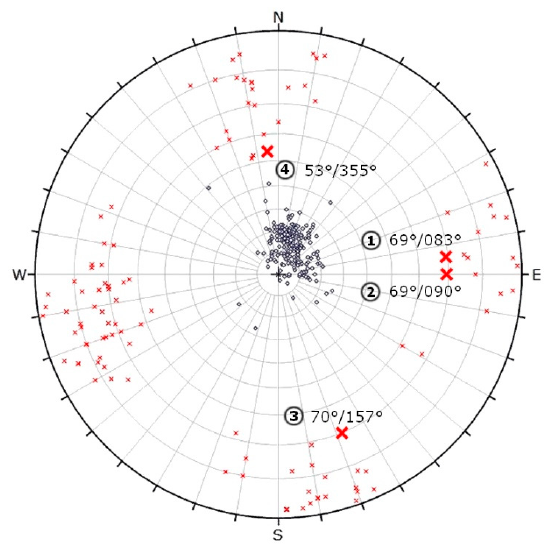
Figure 12. Stereographic projection of discontinuities using equal angle projection to the upper hemisphere with pole vectors and polar stereonet with highlight of the four major faults (x ~ fault, o ~ bedding). The four major faults are numbered: 1–4.